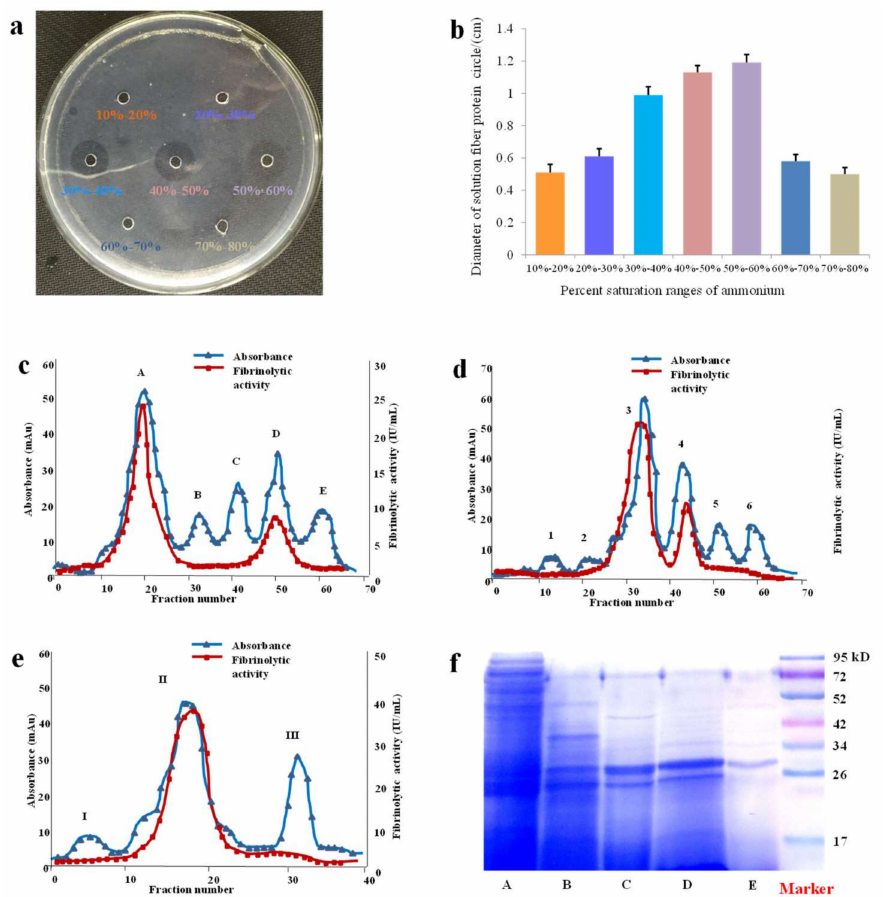
Figure 1. Fibrinolytic activity of protein precipitated by different percent saturation ranges of (NH 4 ) 2 SO 4 and purification of SK. ( a ) Fibrin plates. ( b ) The diameter of fibrinolytic circle affected by protein extract precipitated with 10–20%, 20–30%, 30–40%, 40–50%, 50–60%, 60–70%, and 70–80% saturation ammonium sulfate ( c ) Ultraviolet absorbance and fibrinolytic activity profile of Phenyl Sepharose High Performanc ( d ) Ultraviolet absorbance and fibrinolytic activity profile of Q Sepharose High Performance. ( e ) Ultraviolet absorbance and fibrinolytic activity profile of Superdex prep grade G-75. ( f ) Electronic analysis of cropped SDS-PAGE for different steps, by extraction (A), (NH 4 ) 2 SO 4 precipitation (B), hydrophobic interaction chromatography (C), ion-exchange column chromatography (D) and gel filtration chromatography (E), and full-length gel is presented in Figure